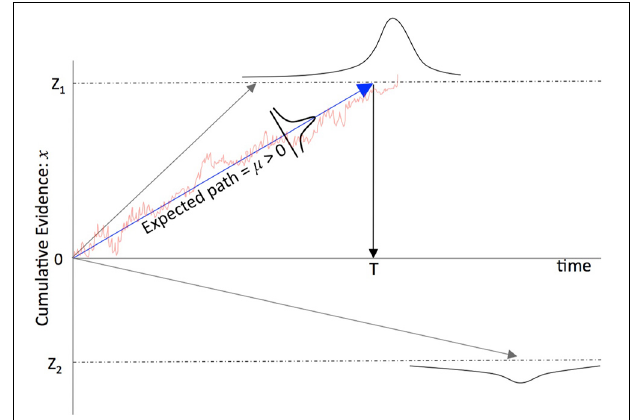
FIGURE 1 | A schematic of the net accumulation of evidence in favor of one choice over another and the mean trajectory followed by the “average” time course of evidence accumulation. μ is the average amount of information received during dt over the time course of evidence accumulation. Note that because there is some statistical variation in the time course of the accumulation of information, for a non-zero σ (cf. Equations 1–4) there is a finite chance that the signal will cross the wrong boundary (and therefore the neuron signals the wrong decision) in the sense that the underlying signal is distorted to the extent that the boundary that is crossed is different from the boundary that would have been crossed in the absence of noise. So as σ increases so too does the chance that the wrong boundary is